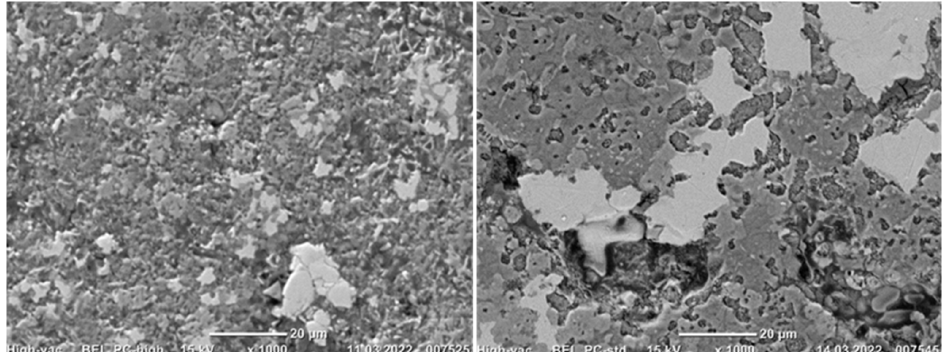
Figure 10. BEI imaging of reduced samples 1 ( left ) and 6. ( right ).